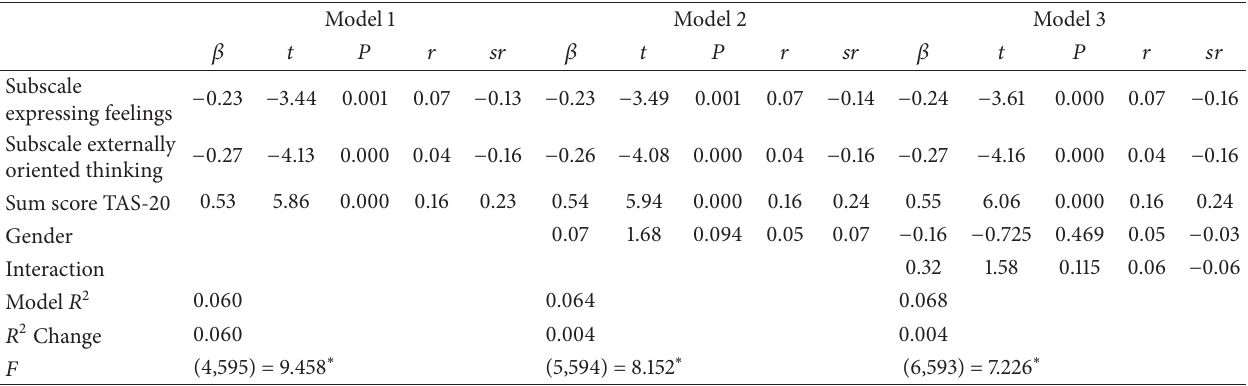
Table 4: Hierarchical multiple regression analyses predicting internet addiction severity from